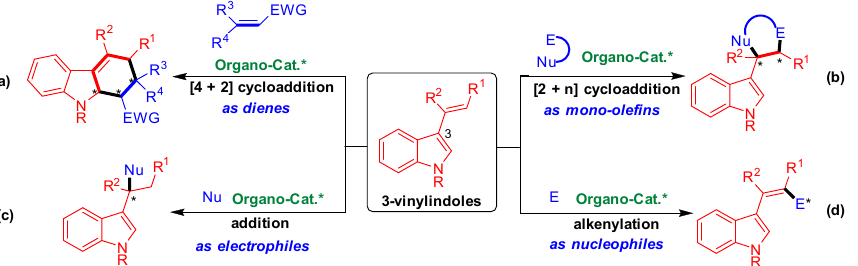
Figure 1. Profile of organocatalytic asymmetric reactions involving 3-vinylindoles. ( a ) [4 + 2] Cycloaddition; ( b ) [2 + n] Cycloaddition; ( c ) Addition reaction; ( d ) Alkenylation reaction. The asterisk * indicates chiral